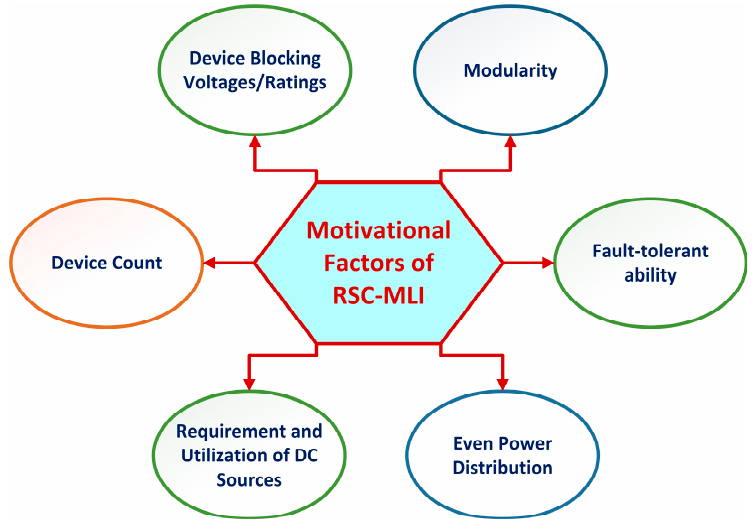
Figure 6. Motivational factors of RSC-MLI.